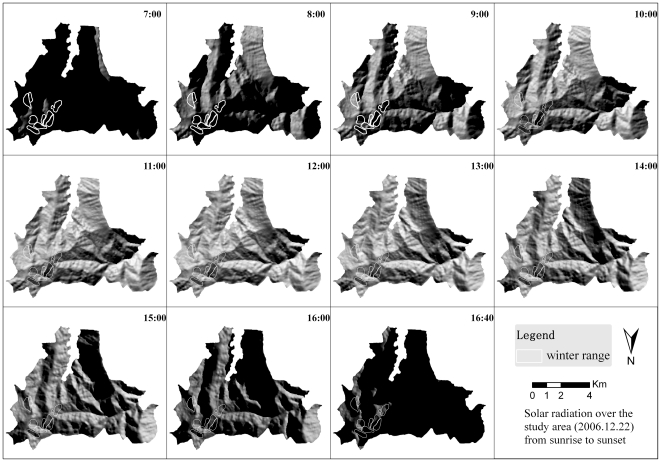
The pattern of solar illumination throughout the monkey's entire home range (3500 to 4500 m) from sunrise (7:00 am) to nearly sunset (16:40 pm) on December 22, 2006.Areas with dark/light color indicate where there is no sun/sun exposure respectively. Higher elevation areas usually have a longer duration of sunlight (the sunlight both begins earlier and ends later in higher areas), indicated by light color.